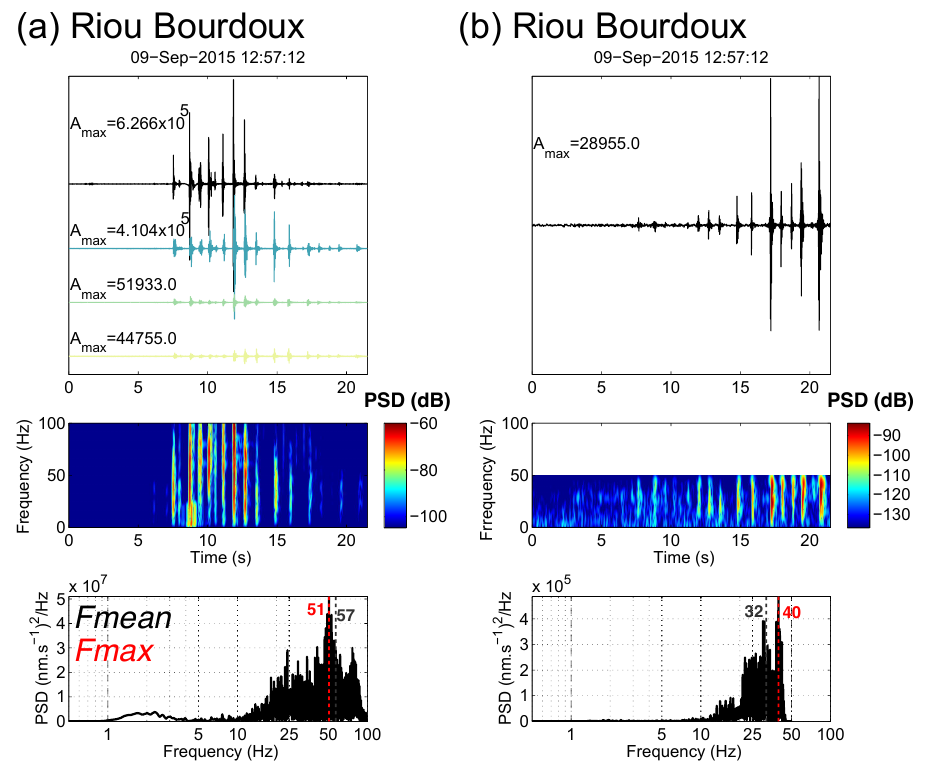
Figure 2. Example of one controlled rockfall (mass = 430kg) at the Riou Bourdoux catchment (Hibert et al., 2017a) recorded by a SP seismometer located at 50m from the rock departure (a) and recorded by a BB seismometer near the rock arrival (b) . The waveforms of the vertical traces are plotted in the upper part of the figure. The amplitude are normalized on the trace with the maximal amplitude (black), the signal recorded by the other sensors (when available) are represented in color below. The maximal amplitudes ( A max ) of all the traces are plotted on the subplot in nms − 1 . The spectrogram is plotted on the middle part of the figure and normalized to the maximal energy. The lower part of the figure represents the PSD of the most energetic trace and the frequency corresponding to the maximum and the mean of the PSD are plotted in red and gray,